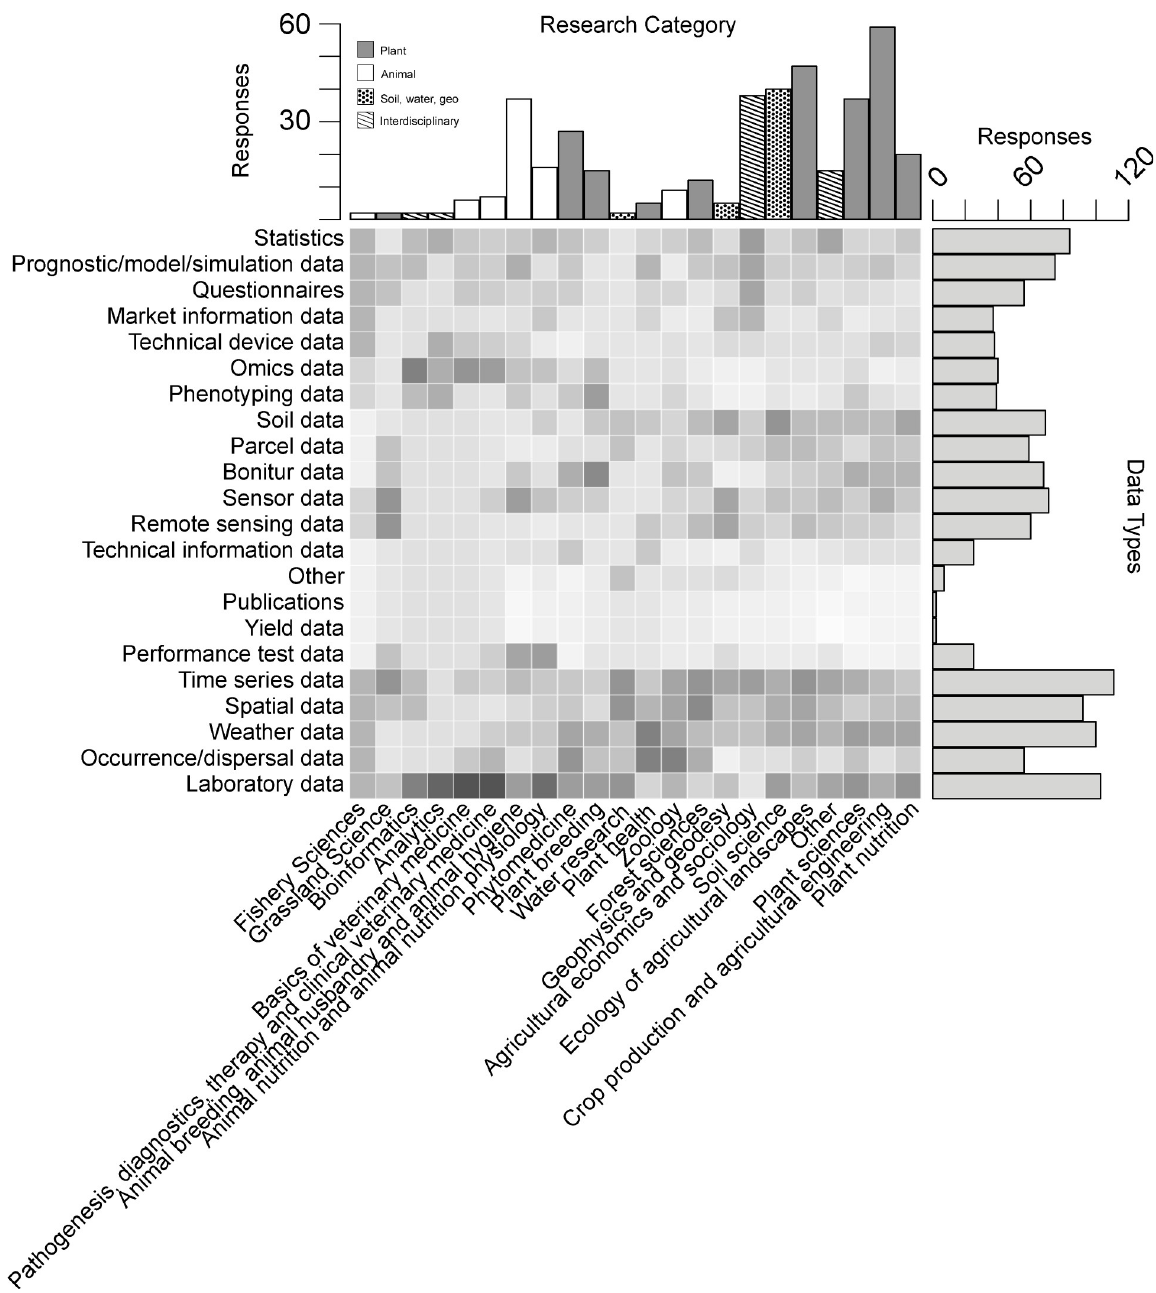
Fig 1. Data types in different agricultural disciplines. The horizontal barplot on top showing the number of respondents that assigned themselves to each of the different agricultural disciplines (Q4). The vertical barplot on the right shows the number of respondents working with the different types of data (Q10). The heatmap shows the relative distribution of data types among the different research categories (N = 191). For better comparability of the various research categories, the values were centered and scaled in each column (i.e. research